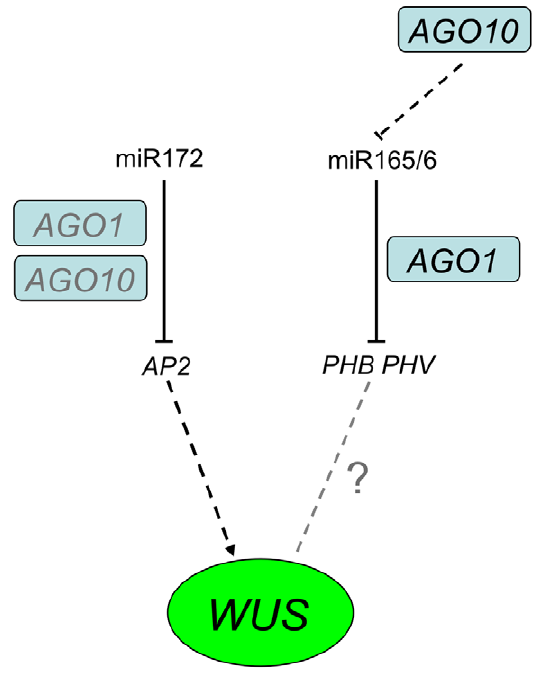
Figure 6. A model of AGO1 and AGO10 in floral stem cell regulation. miR172 promotes floral stem cell termination by repressing the expression of AP2 , which promotes WUS expression. Both AGO1 and AGO10 are associated with miR172 in vivo and genetic evidence supports a role of AGO10 in mediating the activities of miR172. miR165/166-mediated repression of PHB and PHV is also necessary for floral stem cell termination. AGO1 and AGO10 exert opposite effects on miR165/166. While AGO1 mediates the activities of miR165/166, AGO10 represses the expression of miR165/166. The relationship between PHB / PHV and WUS is unknown. Interactions that are potentially indirect are represented by dotted lines.